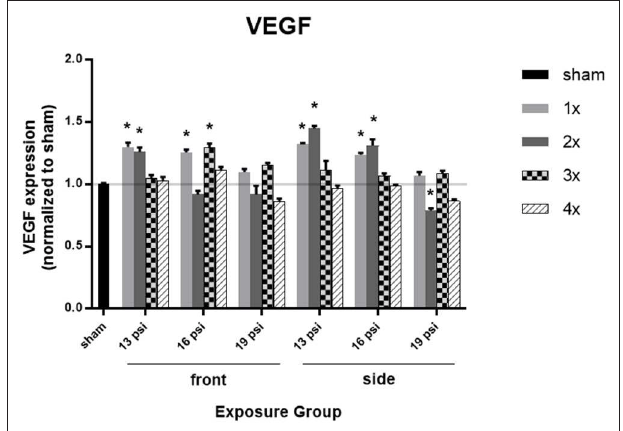
FIGURE 2 | Quantification of VEGF expression measured by ELISA. Results presented as blast intensity for each orientation (front vs. side). Statistical significance compared to sham: * p < 0.05 (Significance values in Supplemental Table 1 ). Data is expressed as mean ± SEM, normalized to